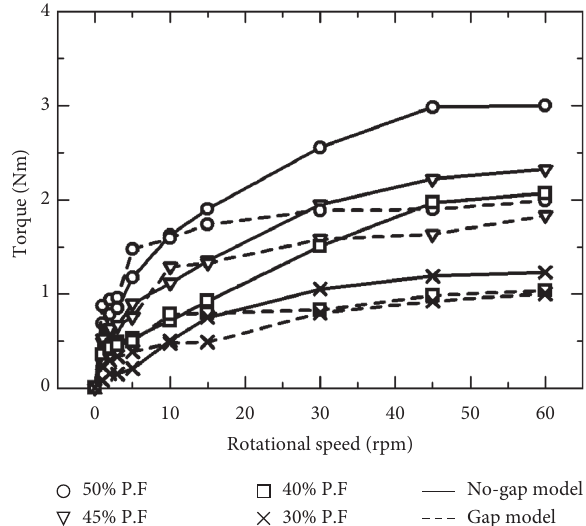
Figure 13: The torque versus rotational speed curve of the rotary damper with gap and no gap using 3mm diameter elastomer particles.